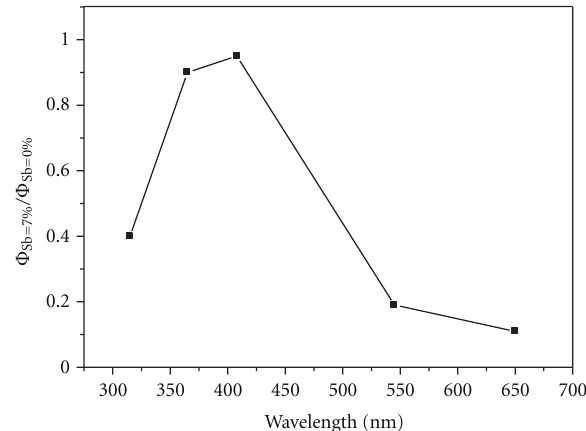
Figure 8: The dependency of the ratio Φ Sb = 7% / Φ Sb = 0% versus the wavelength of